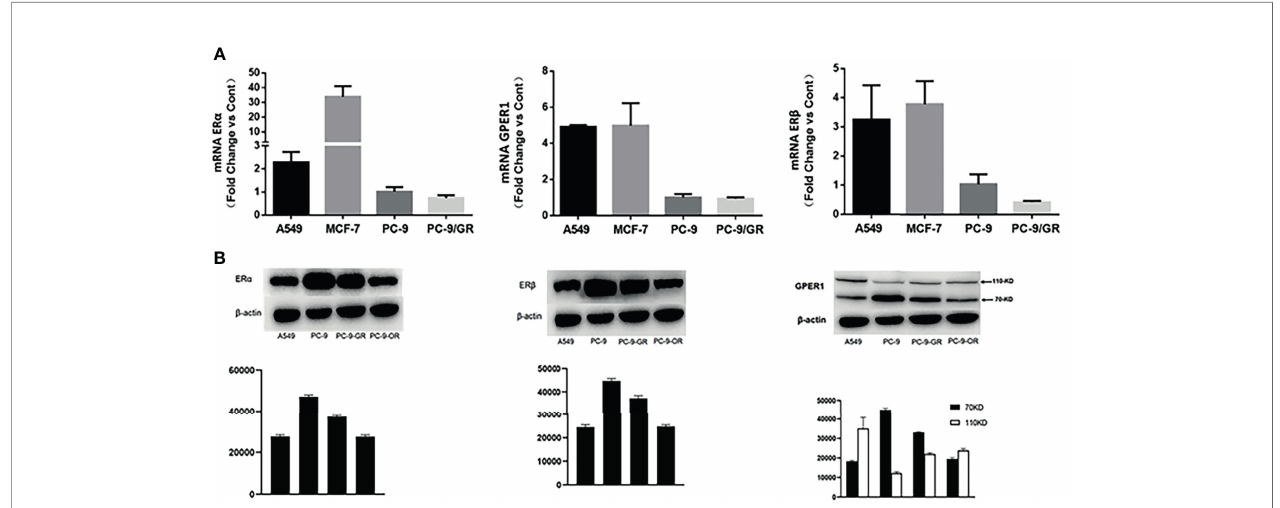
FIGURE 2 | The expression changes of ER a , ER b , and GPER1 at mRNA (A) and protein (B) level with the development of EGFR-TKIs